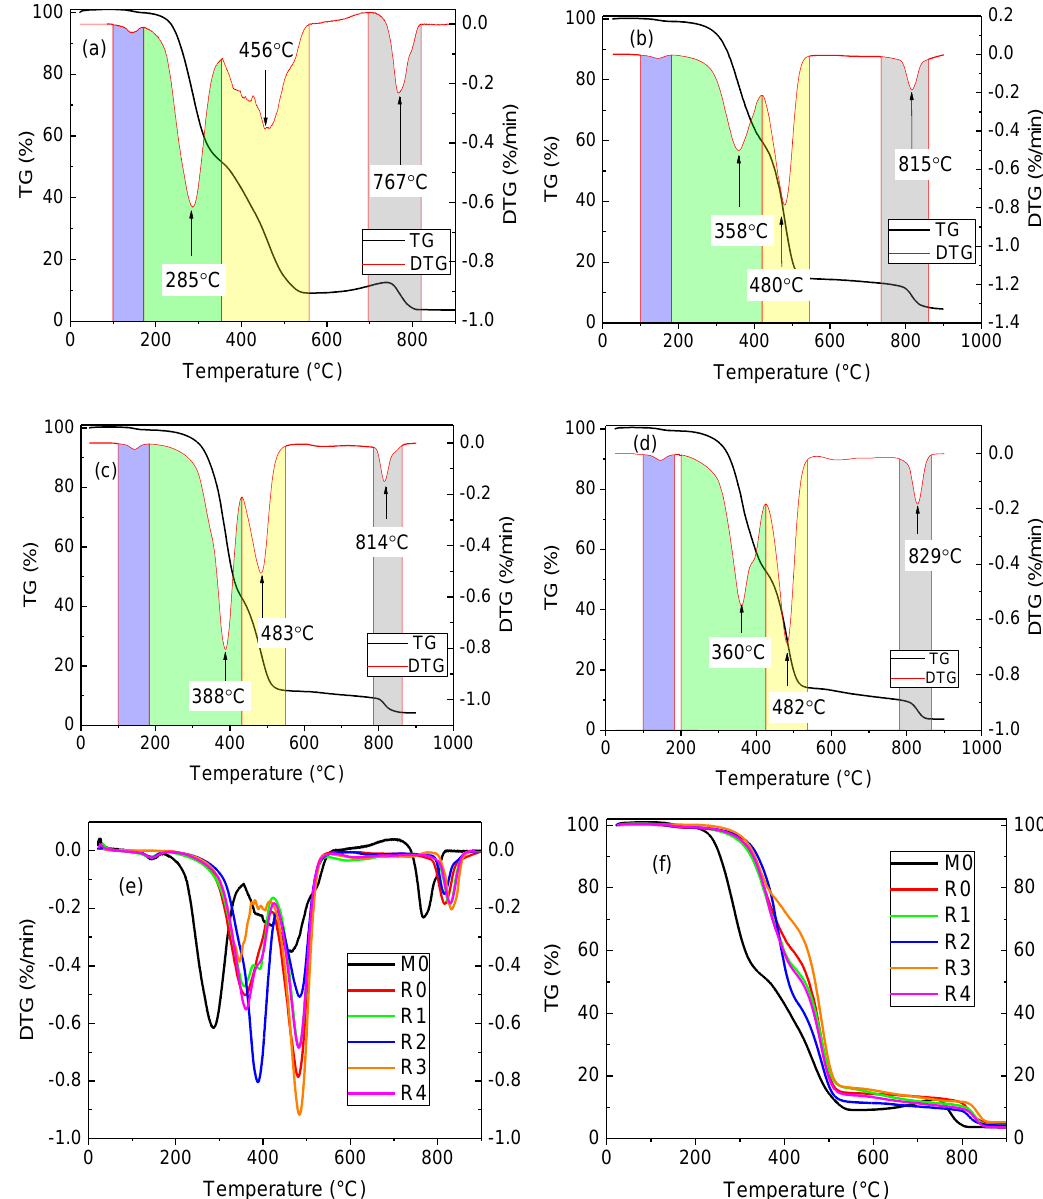
Figure 5. TGA results of thickener and base oil mixture: ( a ) M0; ( b ) R0; ( c ) R2; ( d ) R4; ( e ) DTG curves for all samples; ( f ) Thermogravimetry (TG) curves for all samples